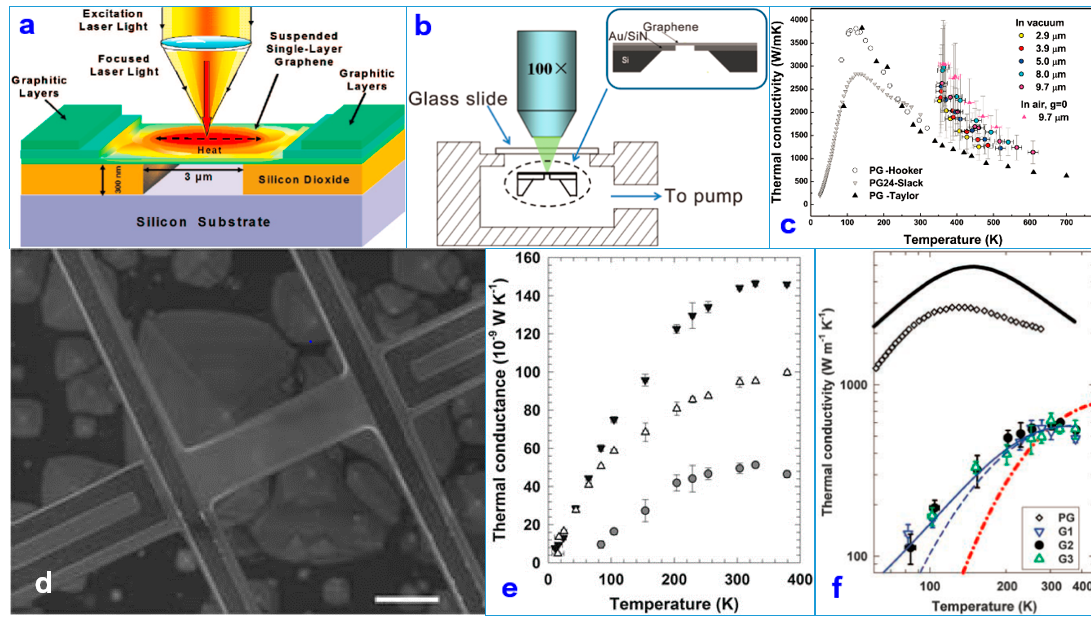
Figure 9. The thermal conductivity (TC) of graphene. ( a ) Schematic of the experiment showing the excitation laser light focused on a graphene layer suspended across a trench [71]. Copyright 2008, American Chemical Society. ( b ) Schematic of the experimental setup for thermal transport measurement of suspended graphene [72]. ( c ) Thermal conductivity of the suspended chemical vapor-deposited (CVD) graphene as a function of the measured temperature of the graphene monolayer suspended in a vacuum over holes of various diameters [72]. Copyright 2011, American Chemical Society. ( d ) SEM image of the suspended device, the central beam, and the folded edge of the SLG ribbon near the right electrode. ( e ) Measured thermal conductance of G2 before (solid downward triangles) and after (unfilled upward triangles) the SLG was etched, with the difference being the contribution from the SLG (circles). ( f ) The relation diagram of thermal conductivity of different samples with temperature change [73]. Copyright 2010,